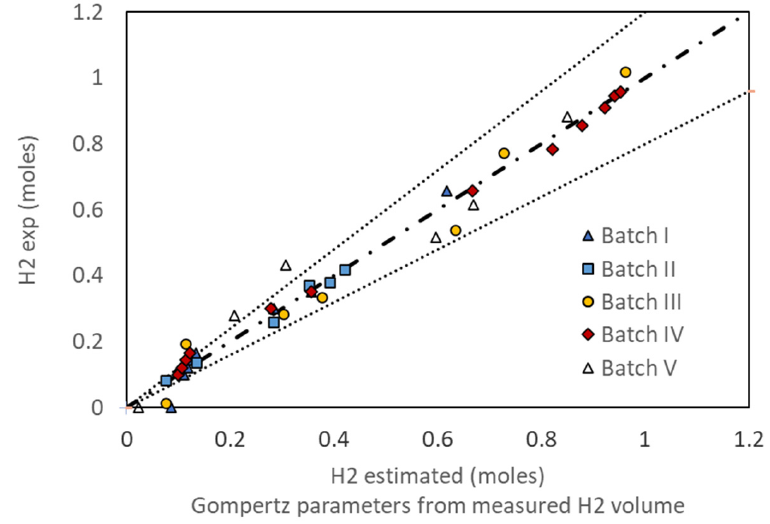
Figure 7. Comparison of experimentally measured moles of H 2 vs. the values predicted by the mod- ified Gompertz model using parameters fitted from the experiments and the pH curve using the function f H and the relation given by Equation (13).